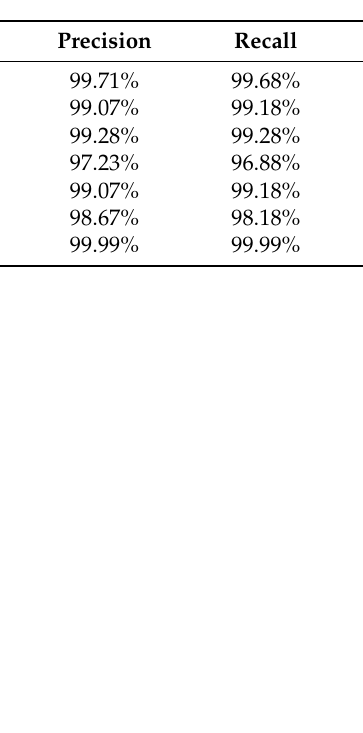
Table 5. Result comparison of classifiers.